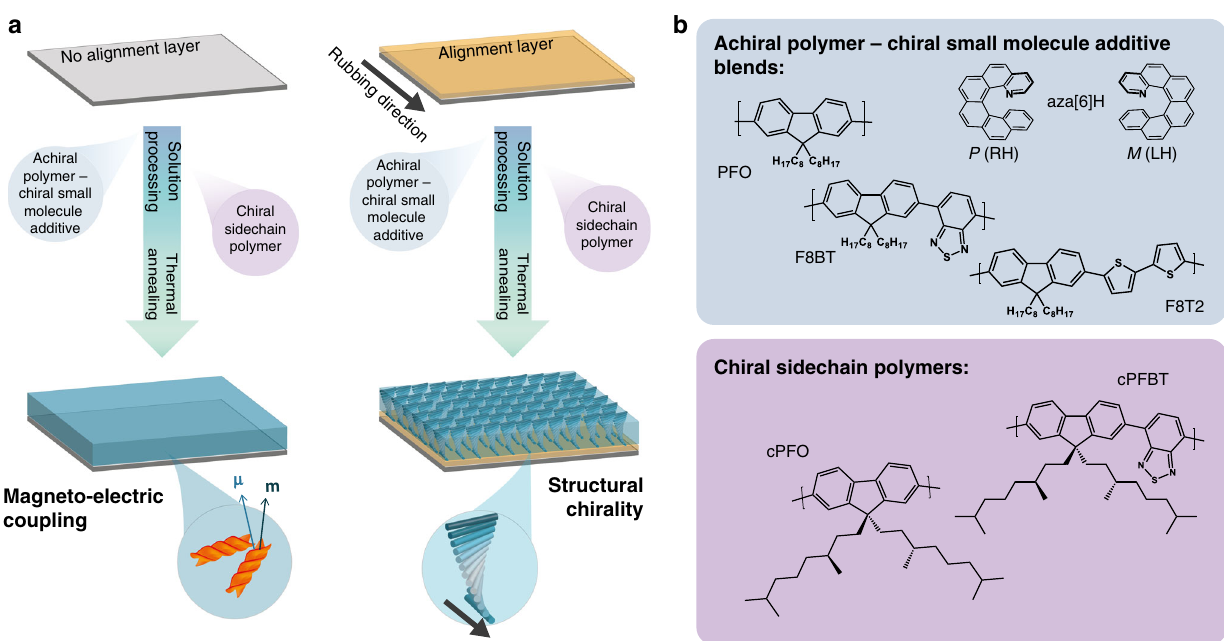
Fig. 1 Origins of the chiroptical effects explored in this work. ( a ) a cartoon depicting the mechanisms that underpin the chiroptical response in non- aligned and aligned thin fi lms and ( b ) the polymer systems evaluated